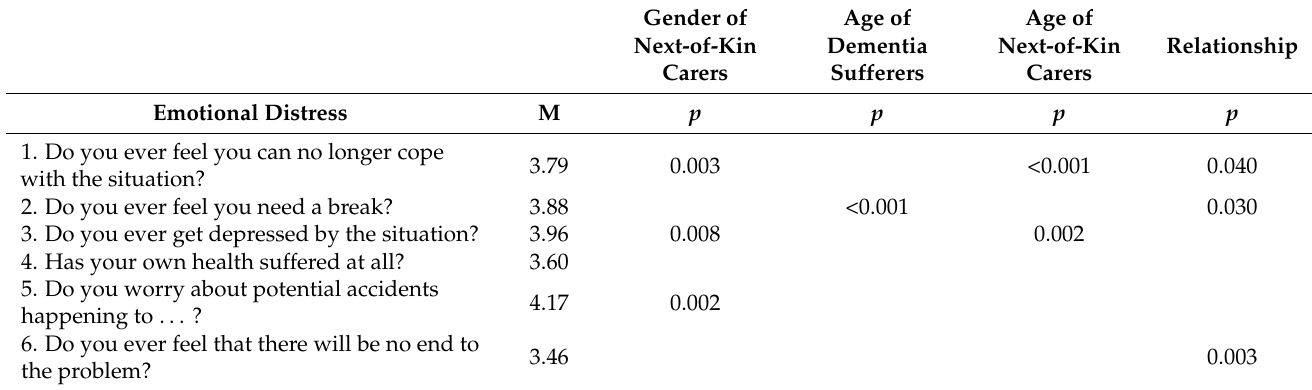
Table 2. Differences in the RSS evaluation based on selected factors.